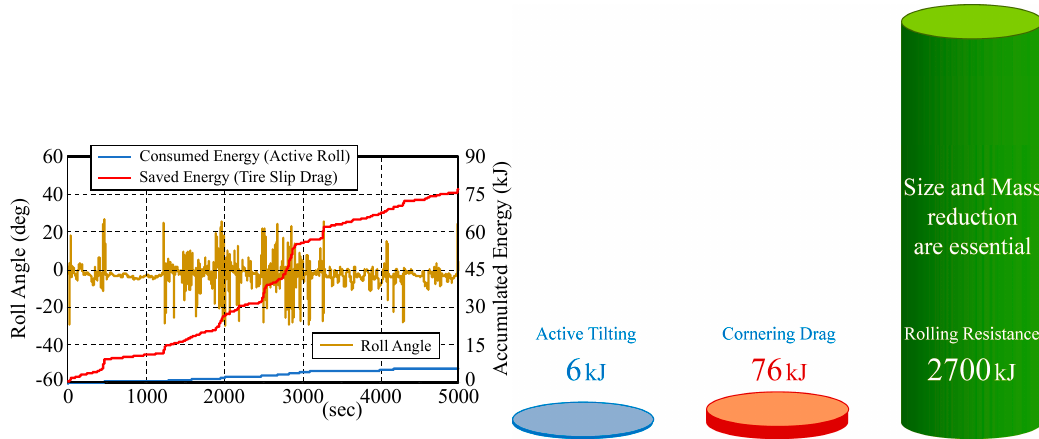
Figure 37. Energy balance on AMS course and comparison with rolling resistance energy.